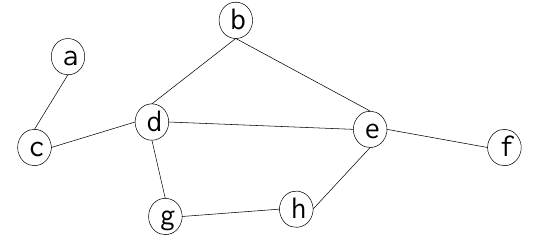
Fig. 1. An example Markov